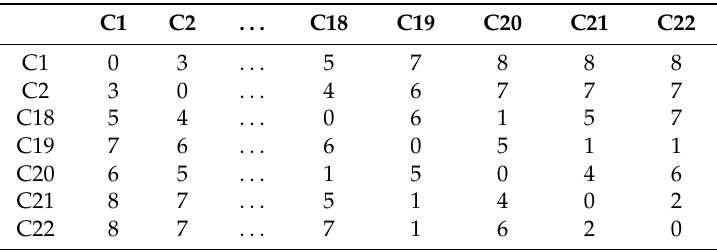
Table 5. The adjacency distance table.